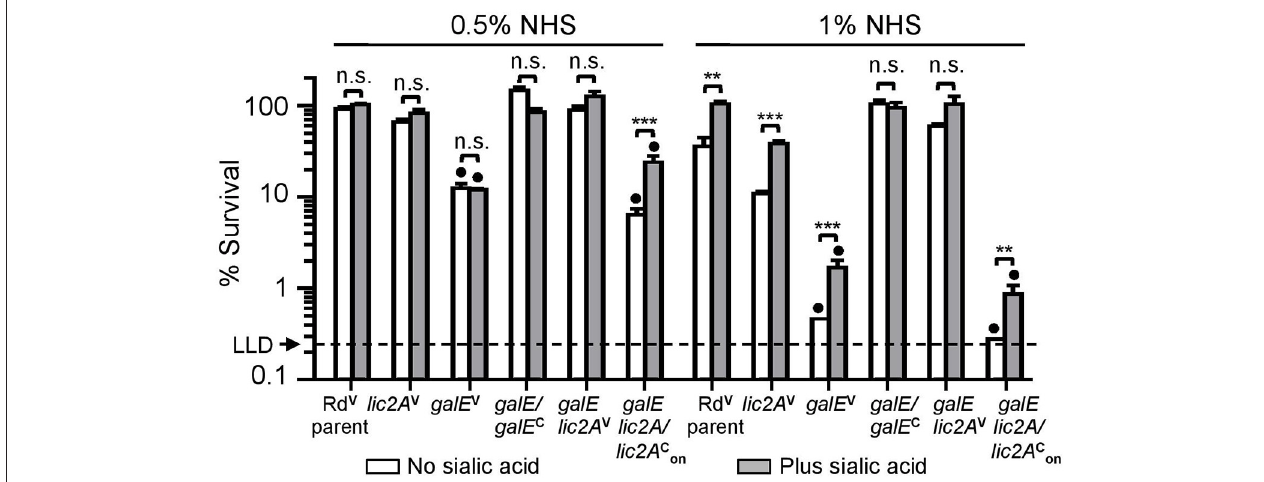
FIGURE 5 | Deletion of lic2A increases serum resistance of the galE mutant when grown in the absence or presence of sialic acid on MIc medium. Viability of Rd containing empty cloning vector (V) (Rd V parent), lic2A mutant containing V ( lic2A V ), galE mutant containing V ( galE V ), galE mutant with complementing copy of galE in trans ( galE / galE C ), galE lic2A mutant containing V ( galE lic2A V ), galE lic2A mutant with complementing copy of phase-on locked lic2A in trans , ( galE lic2A / lic2A C on ) following incubation with 0.5% and 1% NHS at 37 ◦ C for 30min. Percent survival is the ratio of CFU recovered at 30min from serum treated samples to CFU recovered from samples treated with NHS 1 i . Statistical significance of log-transformed survival ratios between each strain ± sialic acid is indicated (one-way ANOVA with Bonferroni’s multiple comparison test; (** p < 0.01; *** p < 0.001; n.s., not statistically significant). galE V and galE lic2A / lic2A C on mutants significantly differed (denoted with black circles, p < 0.001) from all other strains except each other in − / + sialic acid in both NHS concentration. The mean of triplicate samples is shown. LLD, lower limit of detection is approximately 0.25%